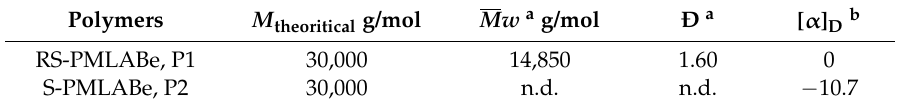
Table 1. Characteristics of the RS-PMLABe (P1) and S-PMLABe (P2). Polymers